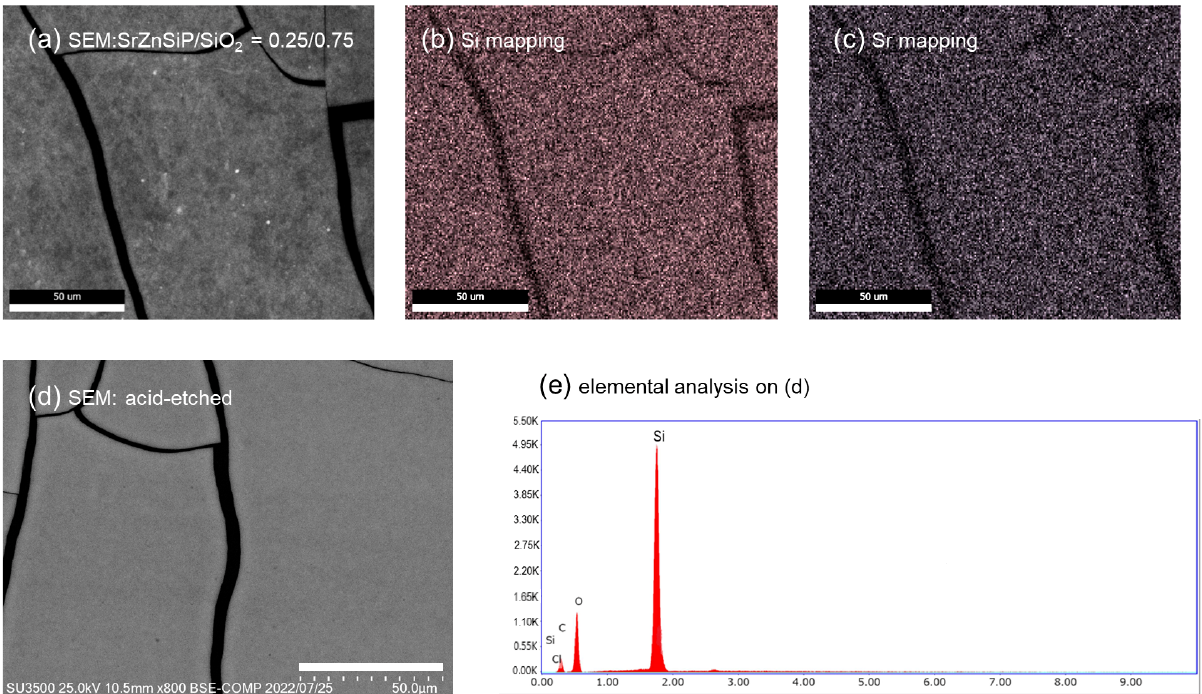
Figure 9. Mapping analyses by SEM/EDS on the coating surfaces of a mixture of SrZnSiP and SiO 2 (0.25/0.75): ( a ) SEM image; ( b ) Si mapping; ( c ) Sr mapping; ( d ) SEM image after acid treatment; and ( e ) elemental analysis of sample ( d